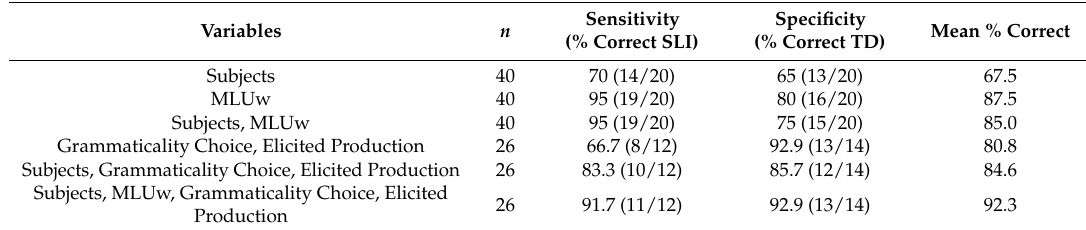
Table 6. Five discriminant functions including subject expression, MLUw, grammaticality choice and elicited production tense results.